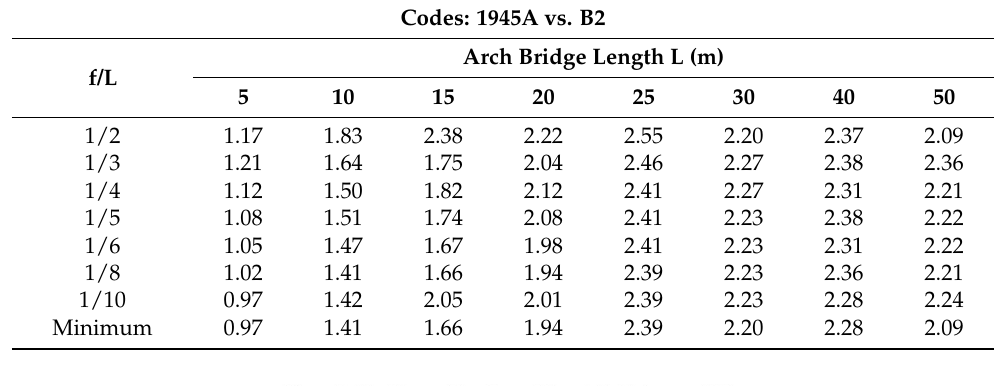
Table 2. Load Rating Factors V for arches designed according to the 1945A code and verified with the B2 load.